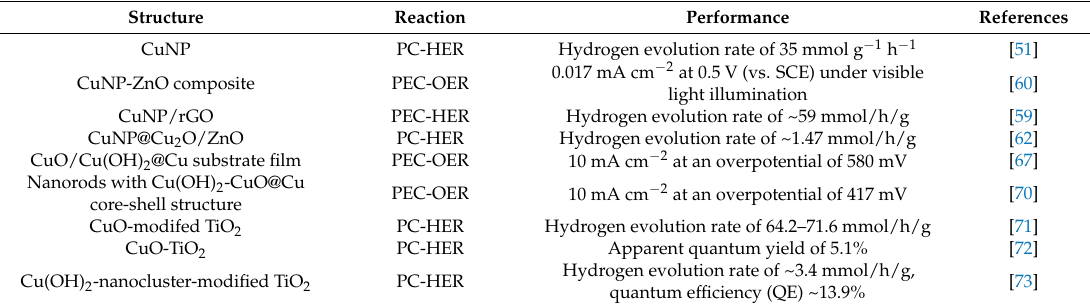
Figure 8. ( a ) HRTEM image of Cu@Cu2O/ZnO nanohybrid, ( b ) UV-Vis spectra of Cu@Cu2O, Cu@Cu2O/ZnO nanocomposites, and ZnO nanorods, ( c ) Schematic of the fabrication process of Cu@Cu2O/ZnO heterojunction nanocomposite. Reproduced with permission from [62]. Copyright John Wiley and Sons, 2018. Table 4. Performance of Cu-based hybrid nanomaterials as photocatalysts (PC) or photoelectrochemical electrodes (PEC).